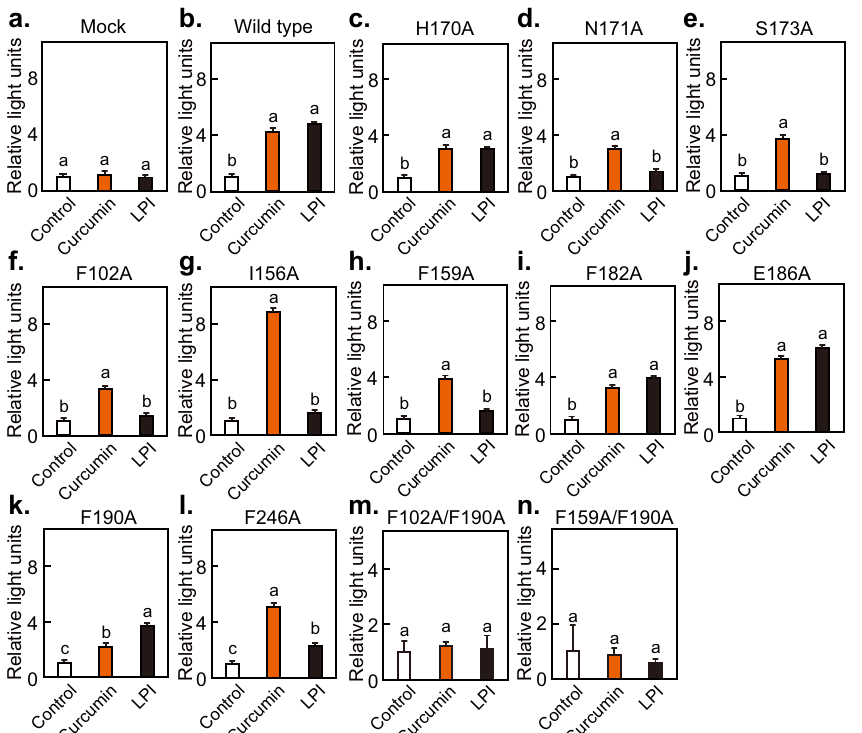
Fig. 6 Identi fi cation of key amino acid residues in GPR55 that interact with curcumin. a – n HEK293-FT cells transfected with wild-type or mutant GPR55 expression vectors and fi re fl y and Renilla luciferase reporter vectors (for serum response element (SRE)-mediated transcription) were stimulated with 10 µM curcumin or 300 nM lysophosphatidylinositol (LPI), and reporter assays were performed. Data are expressed as the mean ± s.d. ( n = 4). Different letters indicate signi fi cant differences ( p < 0.05). a. b.